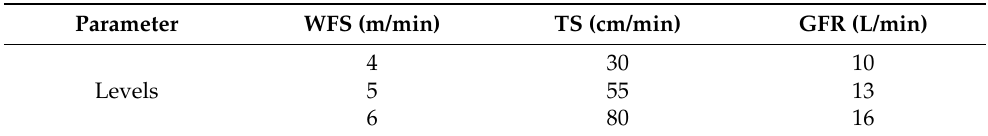
Table 2. Three levels of process parameters, applied to optimize a single bead using the RSM approach in the WAAM process.